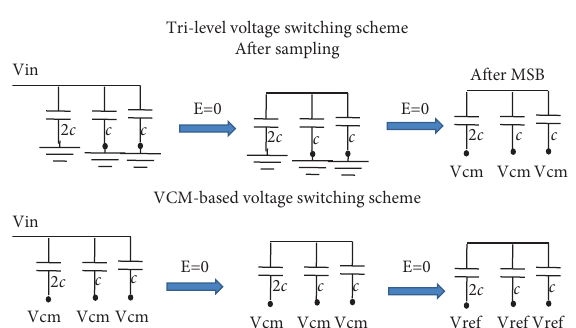
Figure 32: Te trilevel and V